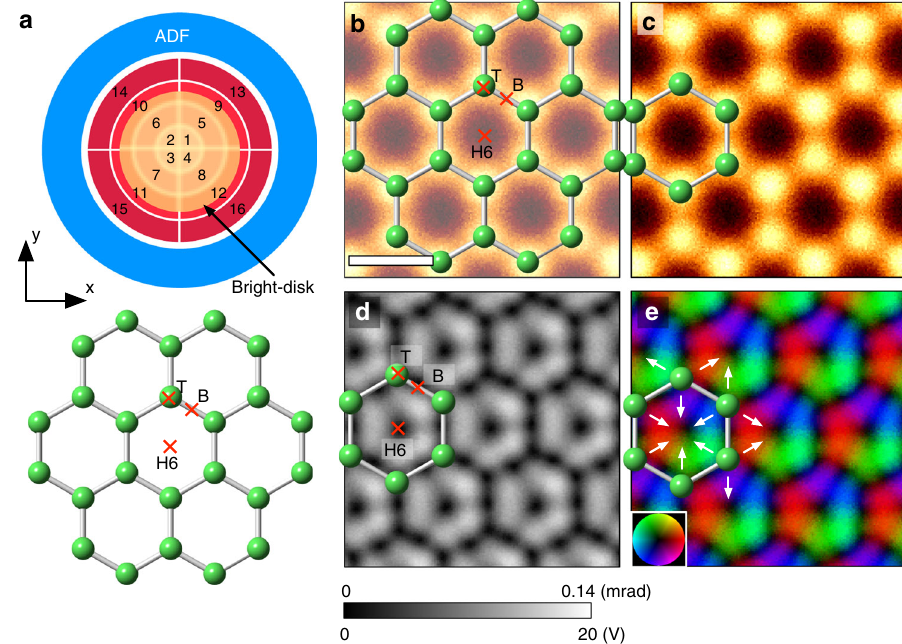
Fig. 1 Projected atomic electric fi eld maps of monolayer graphene. a Schematic view of the orientation relation between the segmented/ADF detectors and the crystal of monolayer graphene. The yellow disk indicates the bright- fi eld region. b , c Atomic-resolution ADF-STEM image, d projected electric fi eld strength map, and e projected electric fi eld vector map. The contrast range in ( d ) is 0 – 20 V or 0 – 0.14 mrad. The scale bar in ( b ) is 2